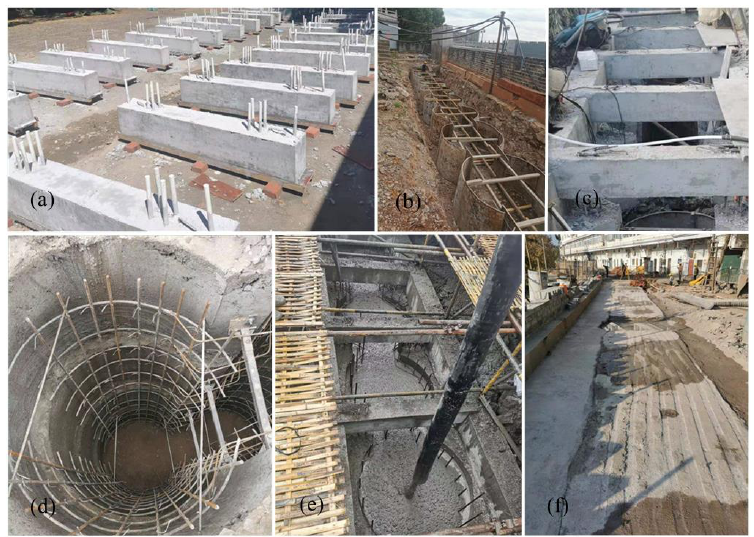
Figure 10. Process of setting antiseepage wall. ( a ) Precast beam; ( b ) well circle formwork; ( c ) locking beam; ( d ) reinforcement binding; ( e ) placing concrete; ( f ) complete.